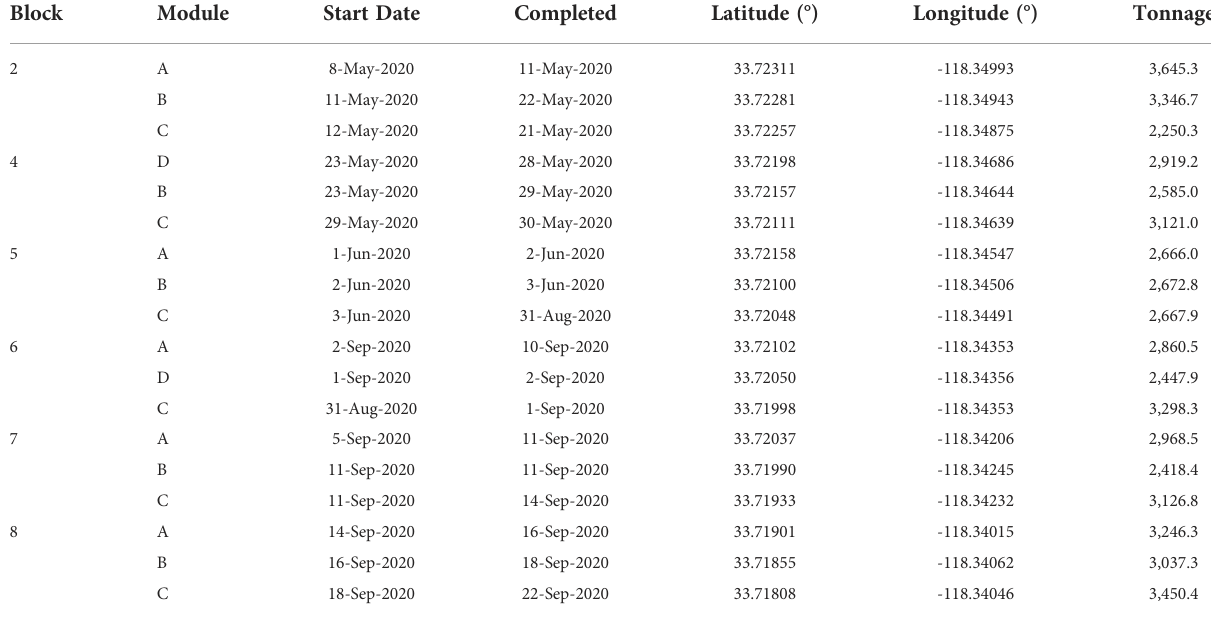
TABLE 1 Start and end of construction dates for each Palos Verdes Reef module.